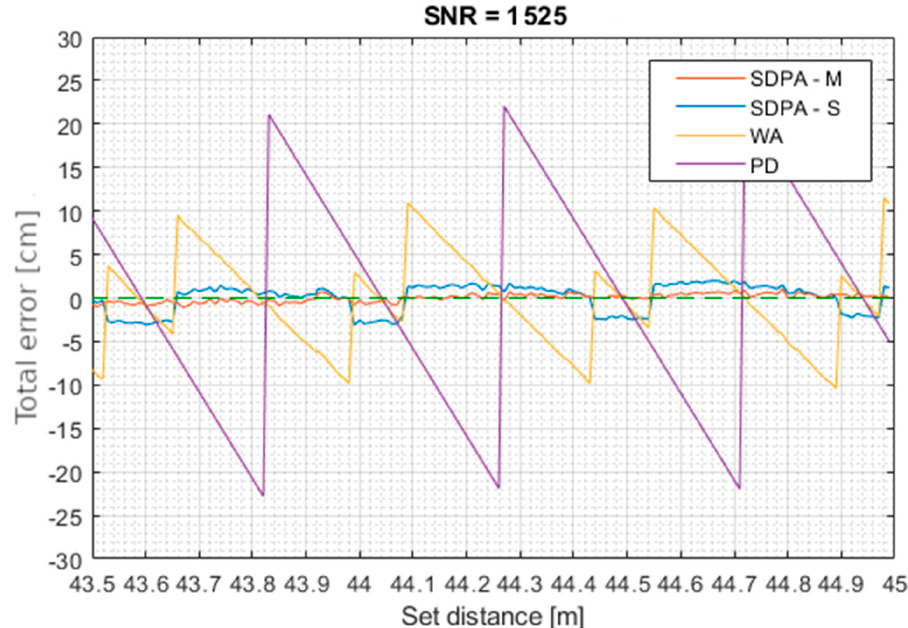
Figure 13. Distance measured with presented algorithms as a function of set distance for SNR = 1525.